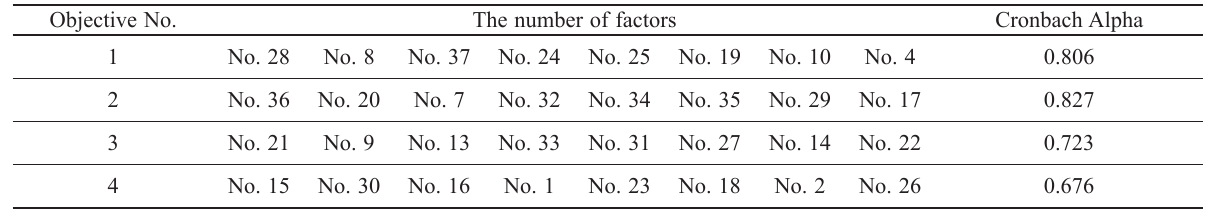
Table 7. The Cronbach’s Alpha of extracted principal components Objective No.